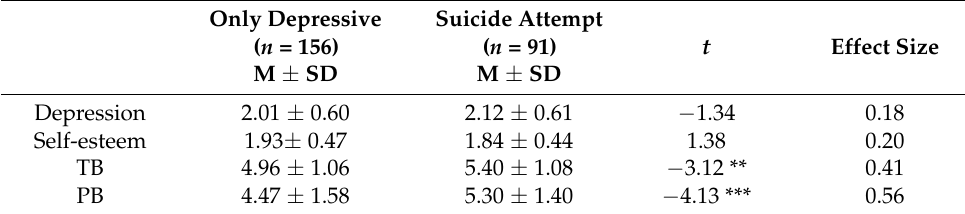
Table 2. Group differences on study variables by suicidal status.